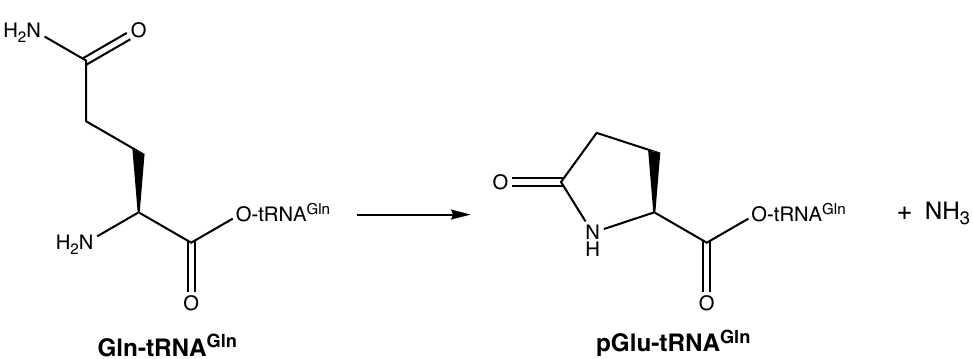
Figure 6. Spontaneous cyclization of glutamine to pyroglutamate. This reaction can occur sponta- neously in solution (not shown) or following aminoacylation of tRNA Gln